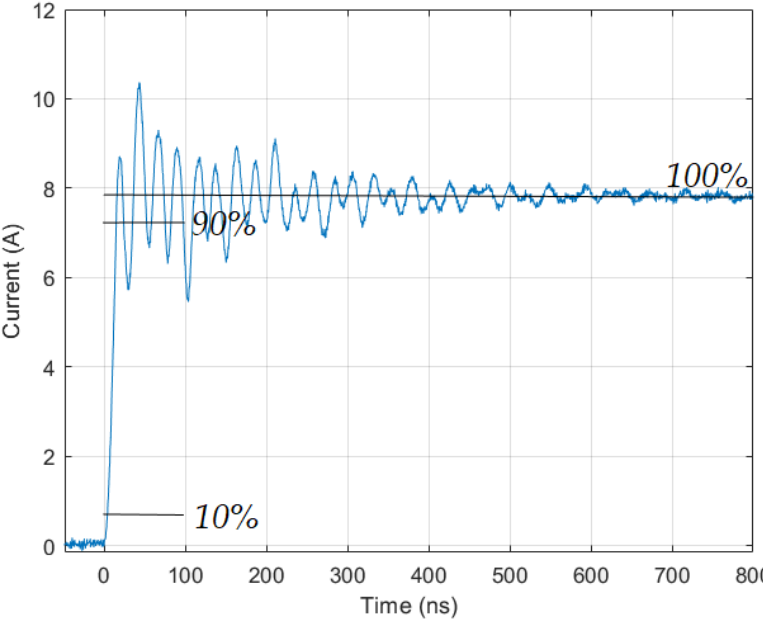
Figure 10. The unfiltered current measured by ALCS, with a rising time equal to 9.13 ns.